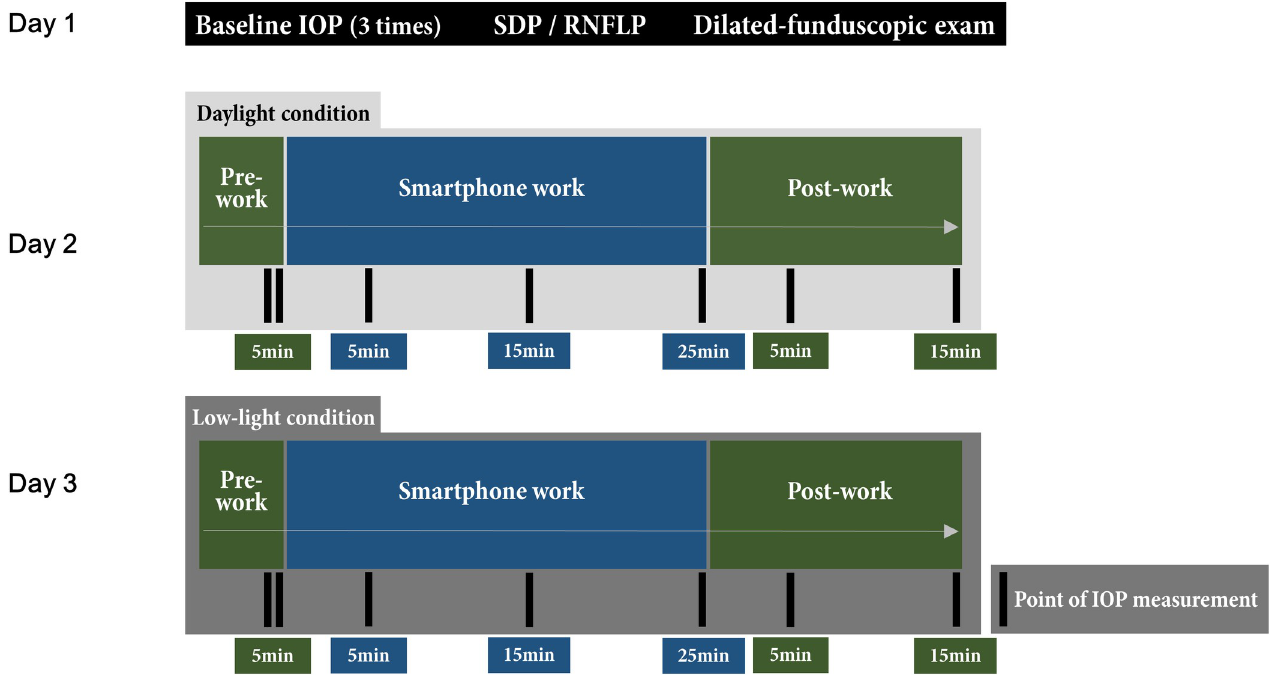
Fig 1. Schematic representation of study protocol. The baseline ophthalmologic examination and smartphone work under daylight and low-light conditions were performed independently on consecutive days.